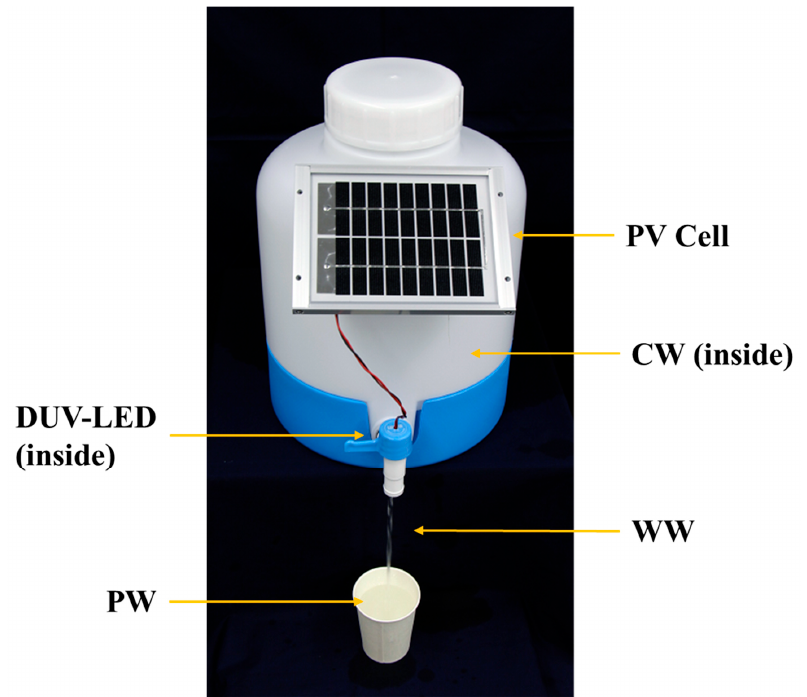
Figure 4. New convenient water purification equipment for emergency preparedness and disaster relief. Contaminated water (CW) containing E. coli bacteria in a water tank (20 L). CW is